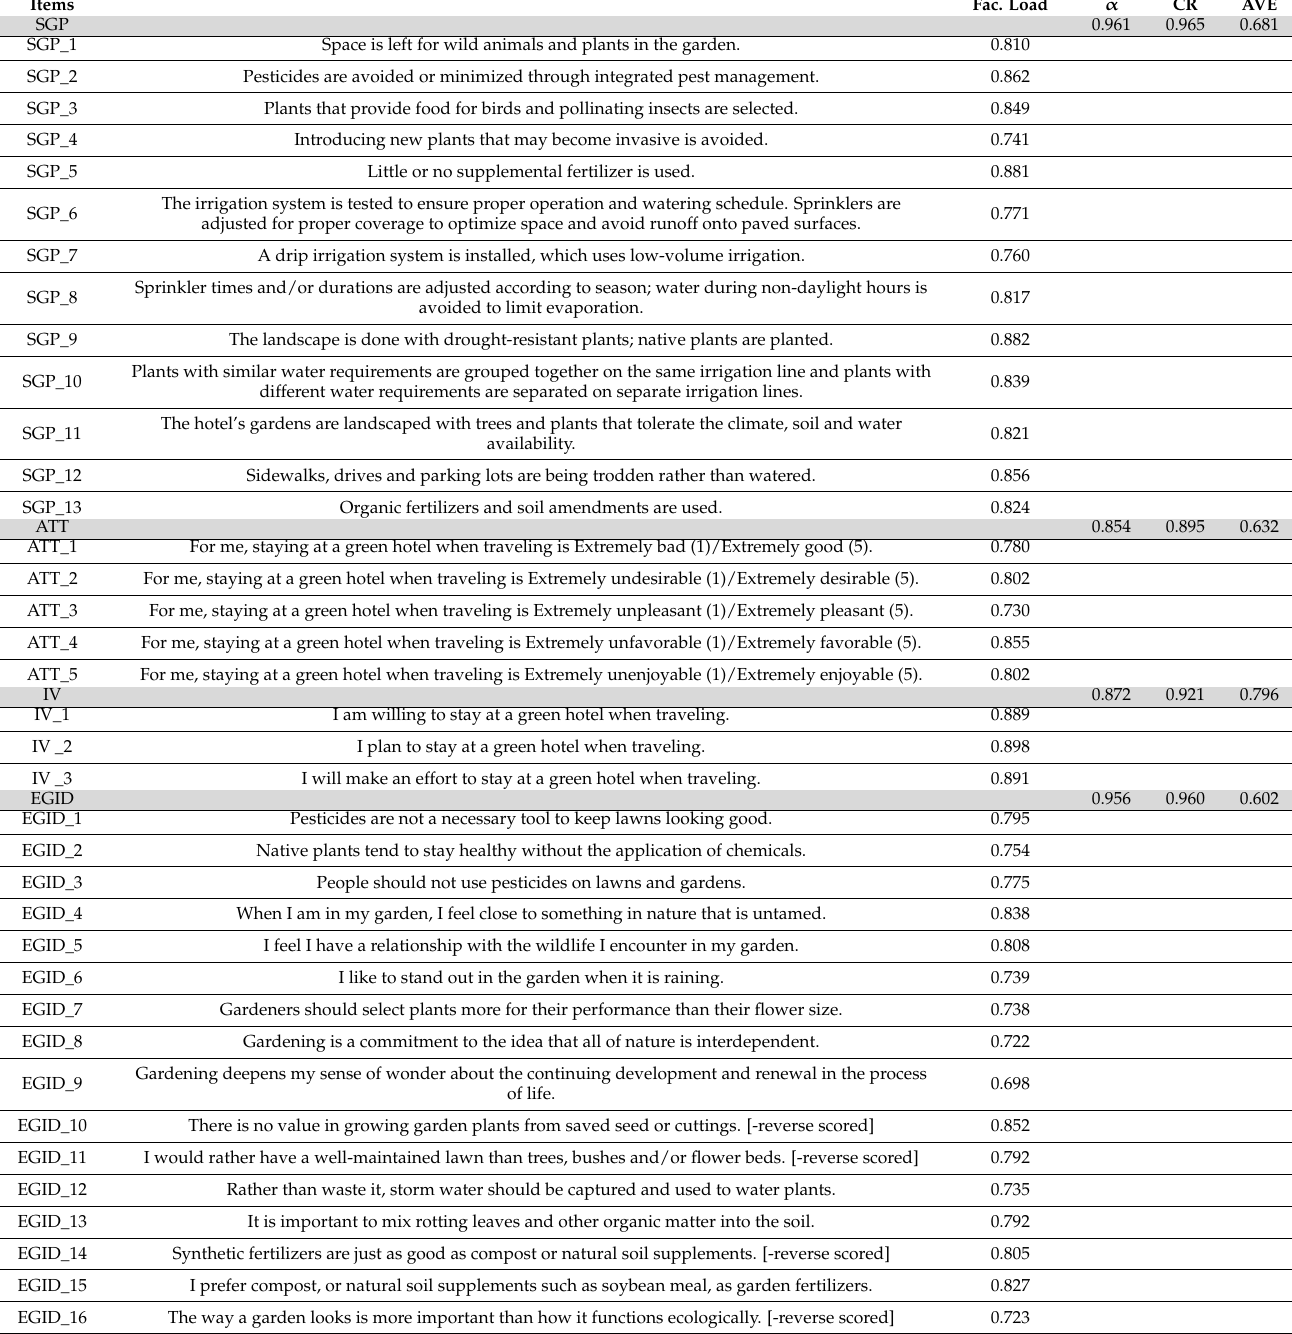
Table 1. Assessment of outer model